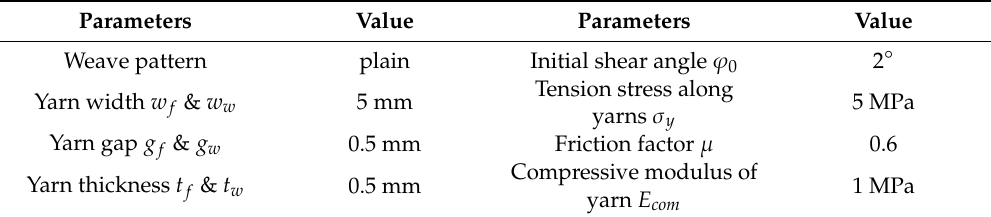
Table 3. Parameter values of a reference-woven